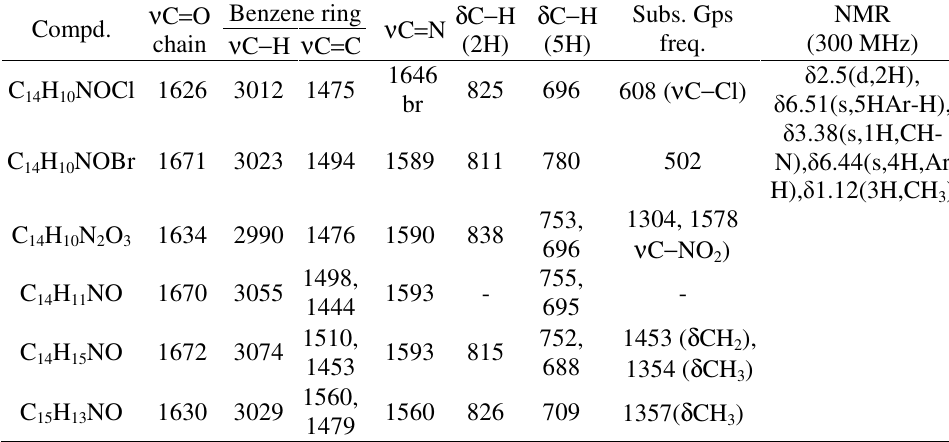
Table 2. Spectral data of